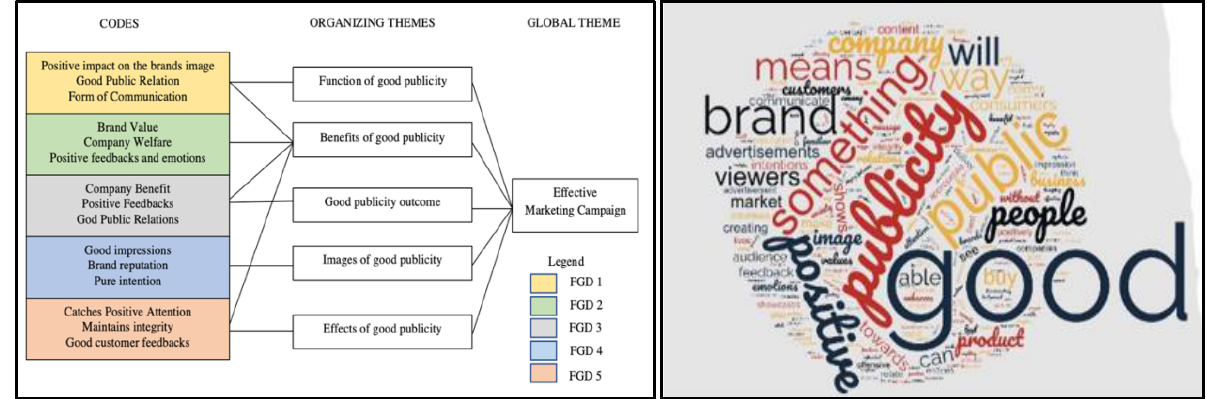
Figure 4: Definition of Good Publicity Figure 3: Concept Map of Good Publicity